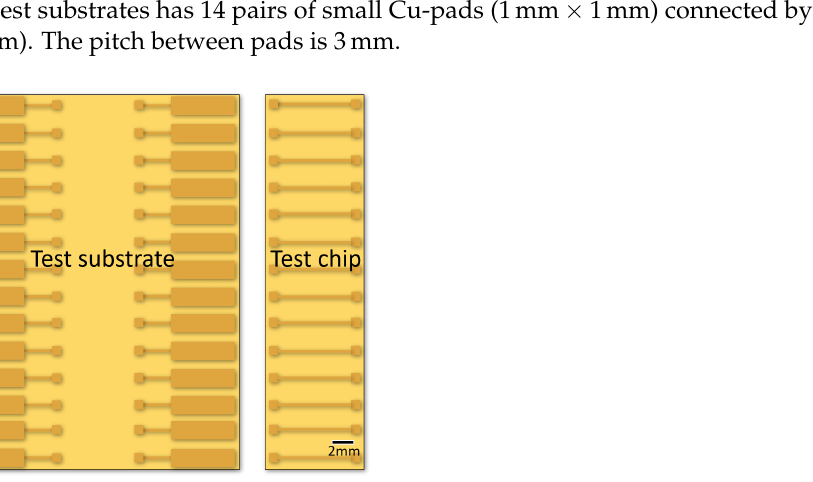
Figure 1. Schematic drawing of the test vehicle applied for the measurement of electrical and mechanical performance of conductive adhesive